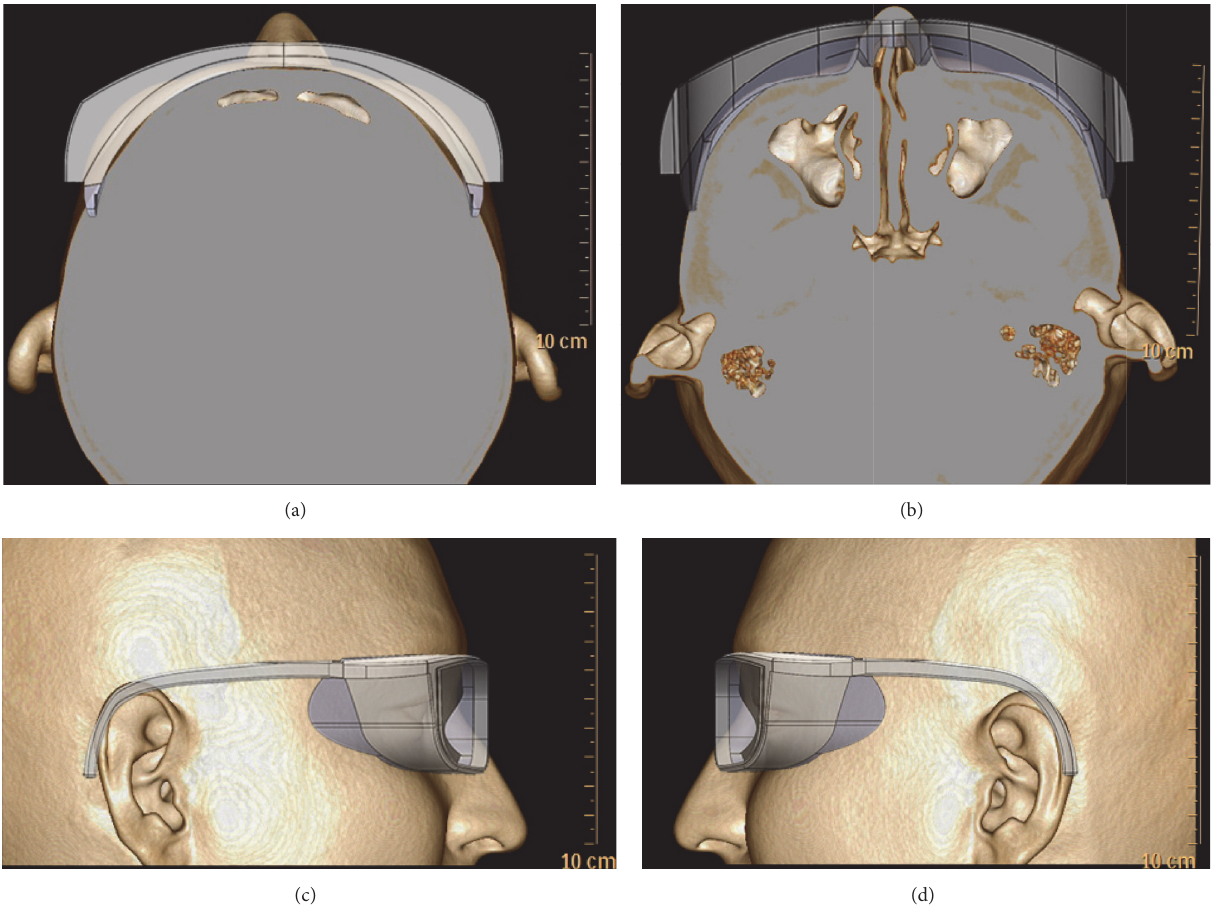
Figure 1: Personalization of moisture chamber spectacles using CT scan images. (a) Top, (b) bottom, (c) right side, and (d) left